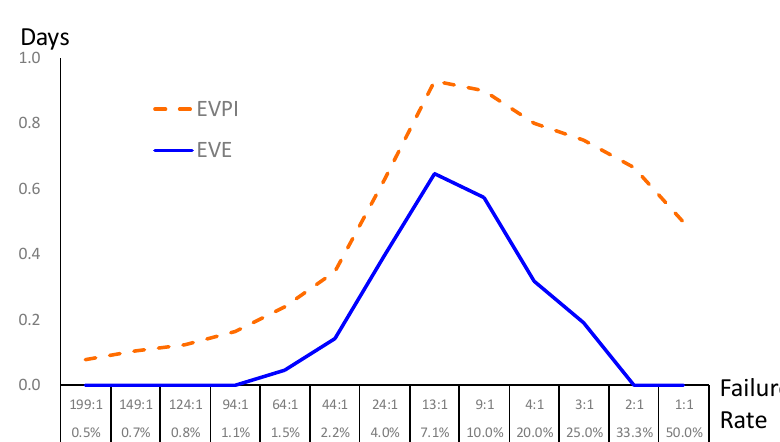
Figure 3. Sensitivity analysis of the failure rate regarding prior probability.